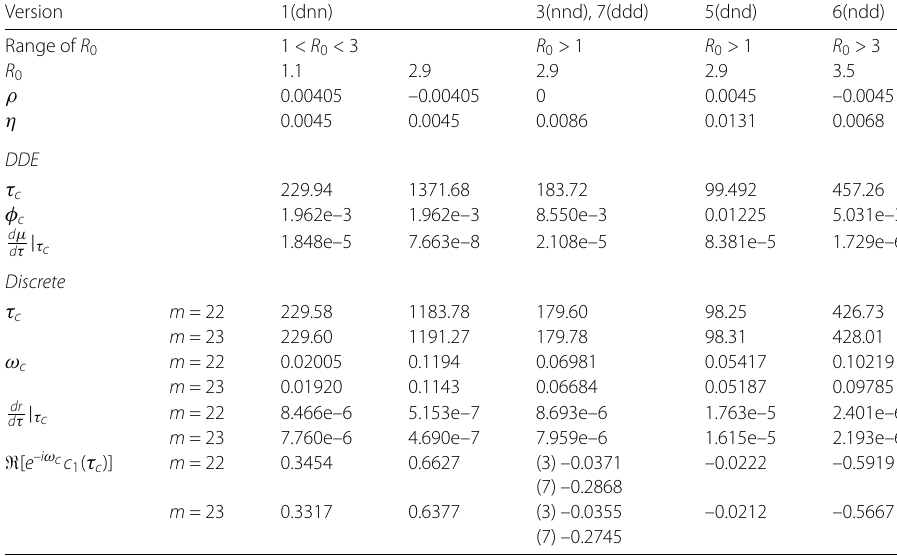
Table 11 Critical bifurcation values for endemic equilibrium of the HIV models Version Range of R 0